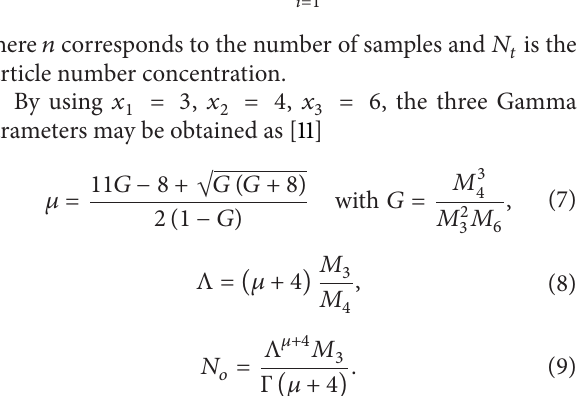
Figure 4: Drop side distribution of average rain rates in Kuala Lumpur from years 1992–1994.